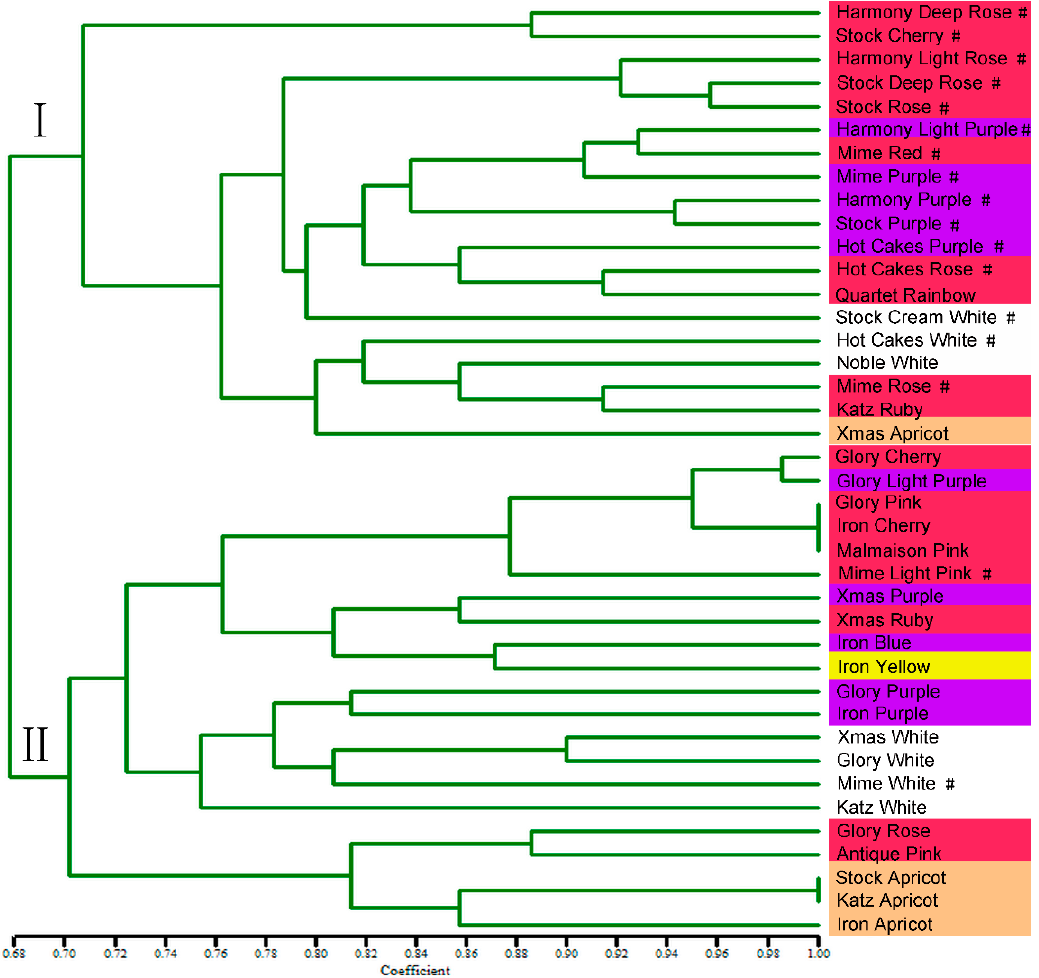
Figure 5. The UPGMA dendrogram of 40 stock cultivars based on 22 SSR markers. # represents potted types. Color bins represent flower colors, that is: the red bins represent deep red, rose, pink, or cherry flower; the purple bins are for deep purple and light purple flowers; the white bins represent white flowers; the yellow bins are for yellow flowers; and the orange bins represent apricot flower.